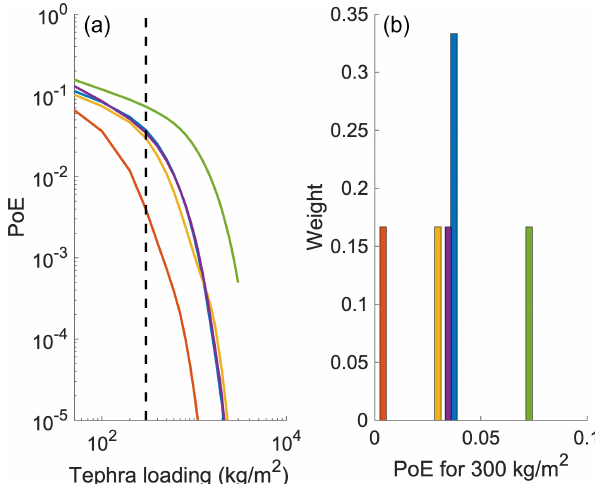
Figure 1. Panel (a) shows the mean tephra-fall hazard curves rela- tive to one point inside the Campi Flegrei (Fig. 2) for each BET im- plementation described in Selva et al. (2018); colors indicate each implementation. Panel (b) shows the PoE relative to the tephra load threshold of 300kgm − 2 (vertical dashed line in a ) and the weight of each